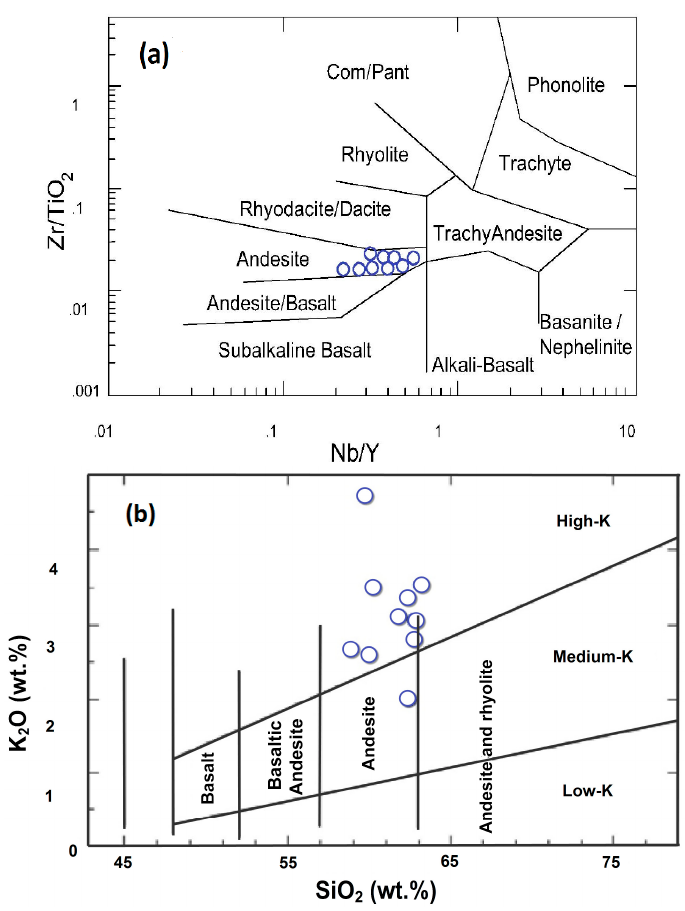
Figure 5. ( a ) Plot of volcanic rocks on Zr/TiO 2 –Nb/Y ratio diagram [26]; ( b ) Position of samples on K 2 O–SiO 2 variation diagram [7].